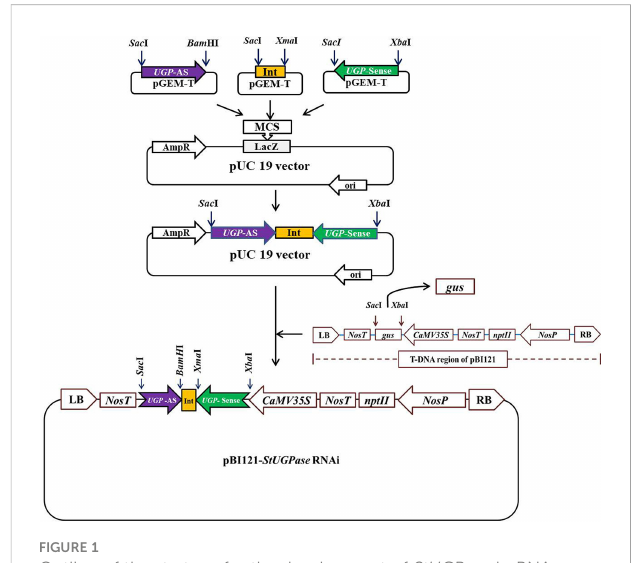
FIGURE 1 Outline of the strategy for the development of StUGPase hpRNA binary vector cassette, pBI121:: UGPase- S: GBSS- Int: UGPase -AS (designated as pB::hpU) for potato transformation. The details of the cloning strategy have been described in Result section